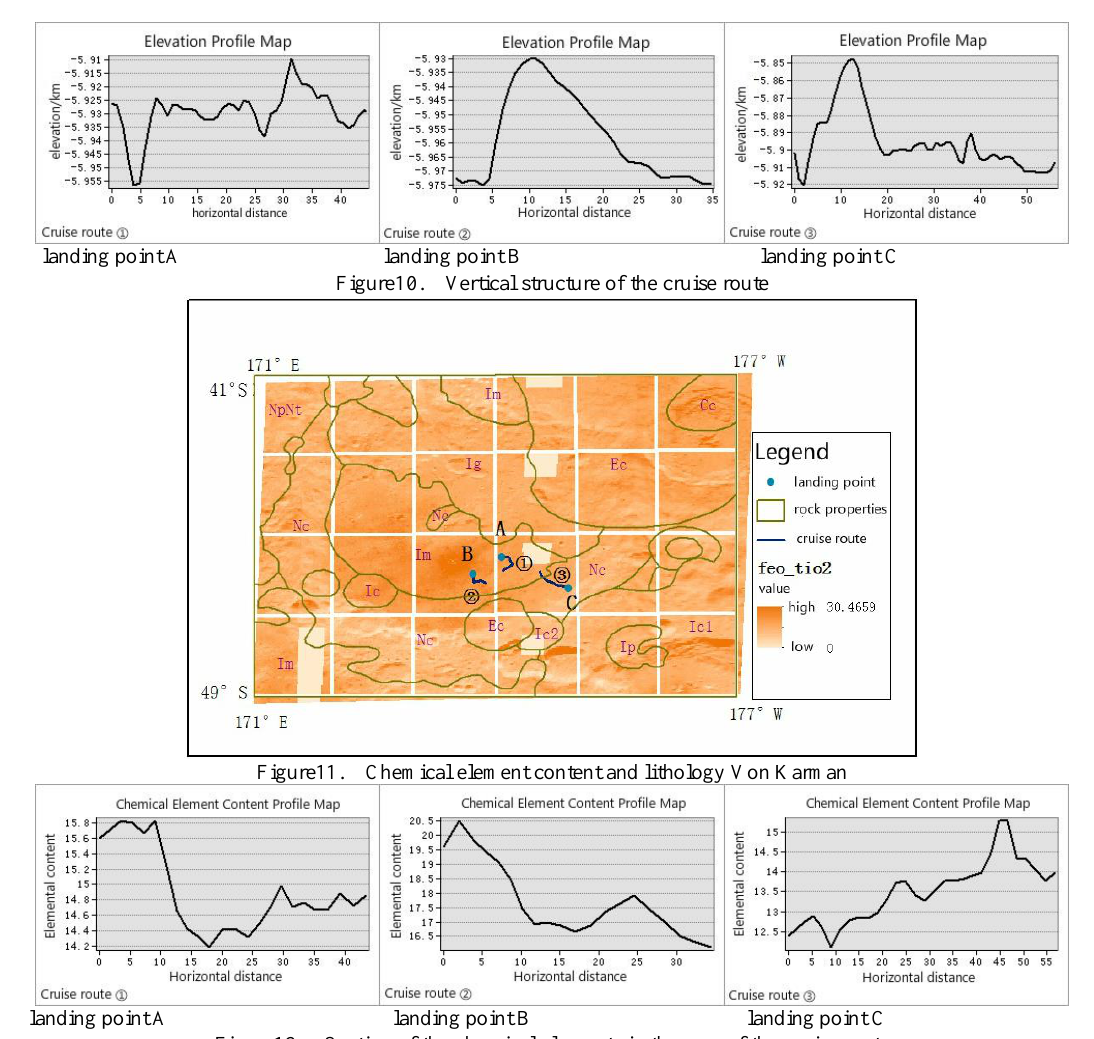
Figure12. Section of the chemical elements in the area of the cruise